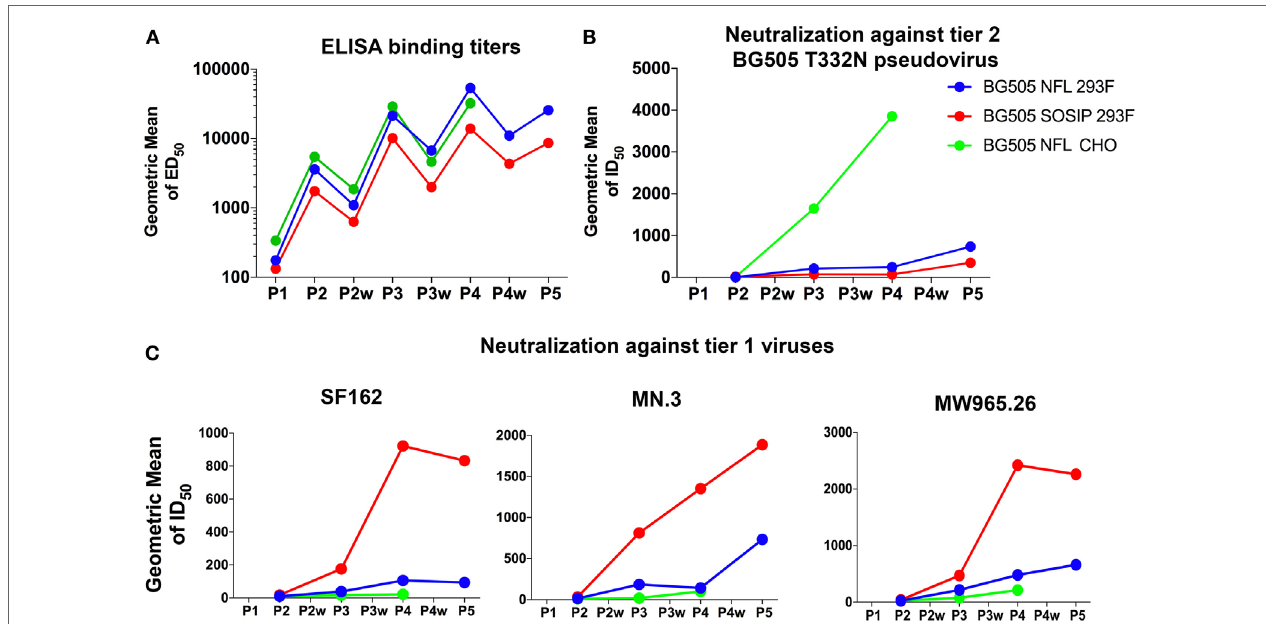
FigUre 7 | Effect of adjuvant on elicitation of tier 1 and tier 2 neutralizing antibodies. (a) Comparison of ELISA binding titers in serum from rabbits immunized with BG505 trimers in ISCOMATRIX [BG505 NFL from CHO-M cells] and Adjuplex (BG505 NFL and BG505 SOSIP from 293F cells) adjuvants after the second, third, fourth, and fifth inoculations. The binding titers are statistically equivalent at all the time points tested. (B,c) Comparison of geometric mean of neutralization ID 50 titers against tier 2 BG505 T332N and tier 1 SF162, MN, and MW965.26 pseudoviruses at the same bleed points. Relatively higher tier 2 and lower tier 1 neutralization titers were observed with ISCOMATRIX adjuvant than Adjuplex indicating that the quality of immune response depends on the effect of adjuvant on the quaternary structure of the trimers and on the subsequent modulation of immune